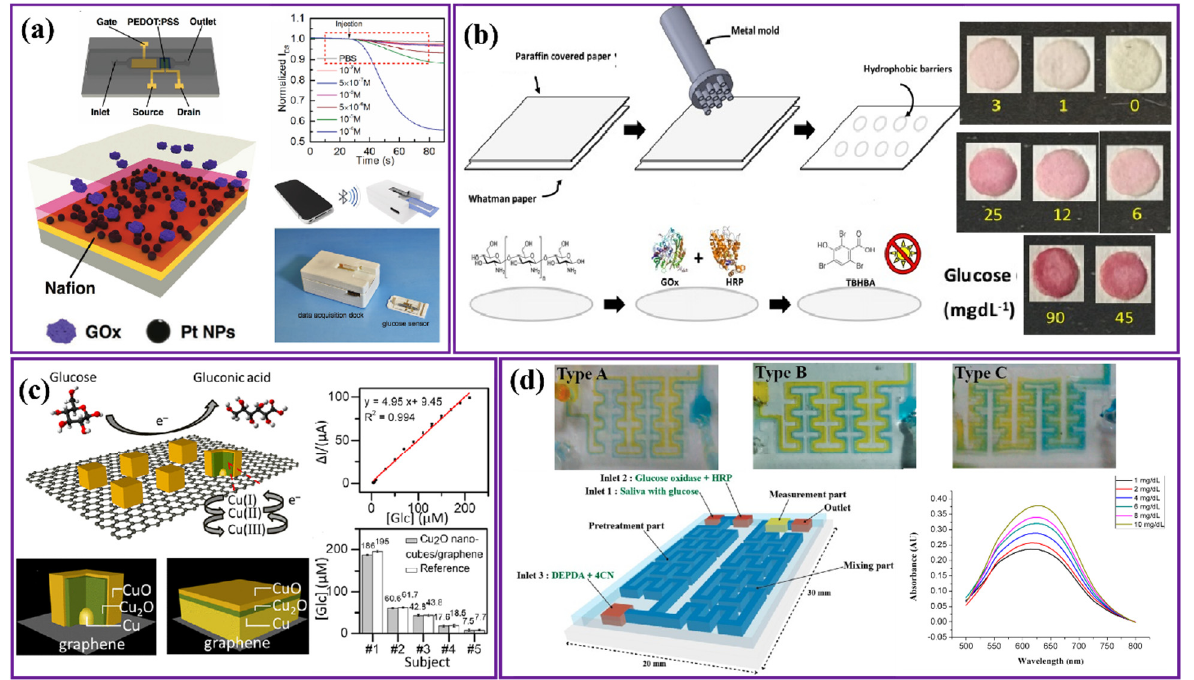
Figure 4. ( a ) Schematic of portable saliva glucose sensor with a thin layer of Nafion that can interact with smartphone. (Reproduced with permission from X. JI et al., Adv. Mater. Technol., vol. 1600042, pp. 1–8, 2016 [50]. Copyright 2016, John Wiley and Sons.) ( b ) Schematic representation of paper-based sensor fabrication, along with the color calibration scale for quantification of glucose concentrations in the sample. (Reproduced with permission from Dominguez et al., Sensors, vol. 18, no. 1071, pp. 1–12, 2018 [54]. Copyright 2018, authors under open access licenses.) ( c ) Mechanism involved in the sensor and schematics of Cu2O nano cube on graphene and Cu film sputter-coated on graphene. (Reproduced with permission from Gao et al., ACS Appl. Nano Mater., May 2021 [17]. Copyright 2021, authors under open access licenses.) ( d ) The proposed micro-channel with different structures in order to improve mixing efficiency. Micro-channel structures: Type A without obstacles, Type B with obstacles, Type C with obstacles and more curvature. (Reproduced with permission from Jung et al., Sensors, vol. 17, no. 2607, pp. 1–12, 2017 [55]. Copyright 2017, authors under open access licenses.)